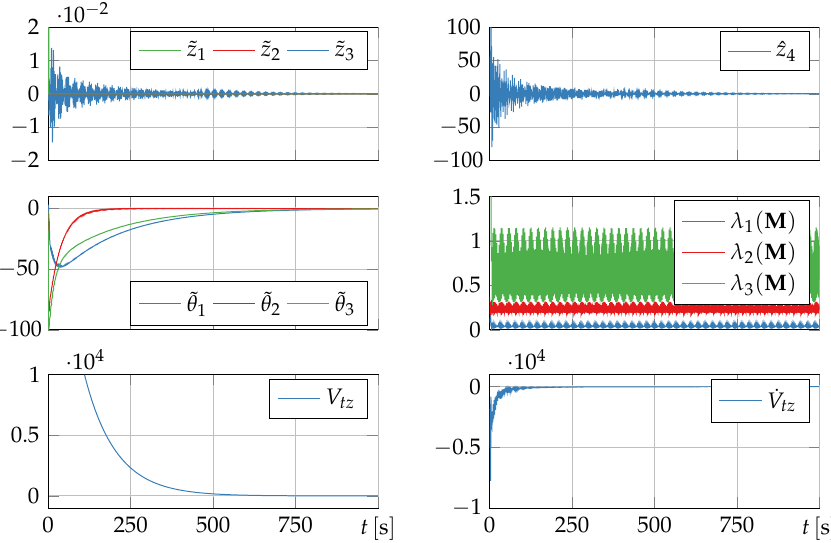
Figure 7. Results of the simulation with regressor depending on the state.